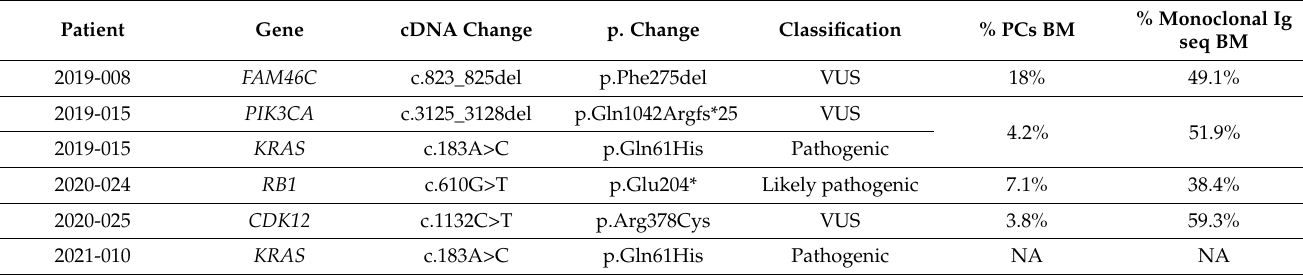
Table 3. Somatic variants selectively detected in BM-DNA. This table gives an overview of the somatic variants that were only detected in BM-DNA ( n = 6) and in neither of the matched liquid biopsy-derived DNA samples. NA = not